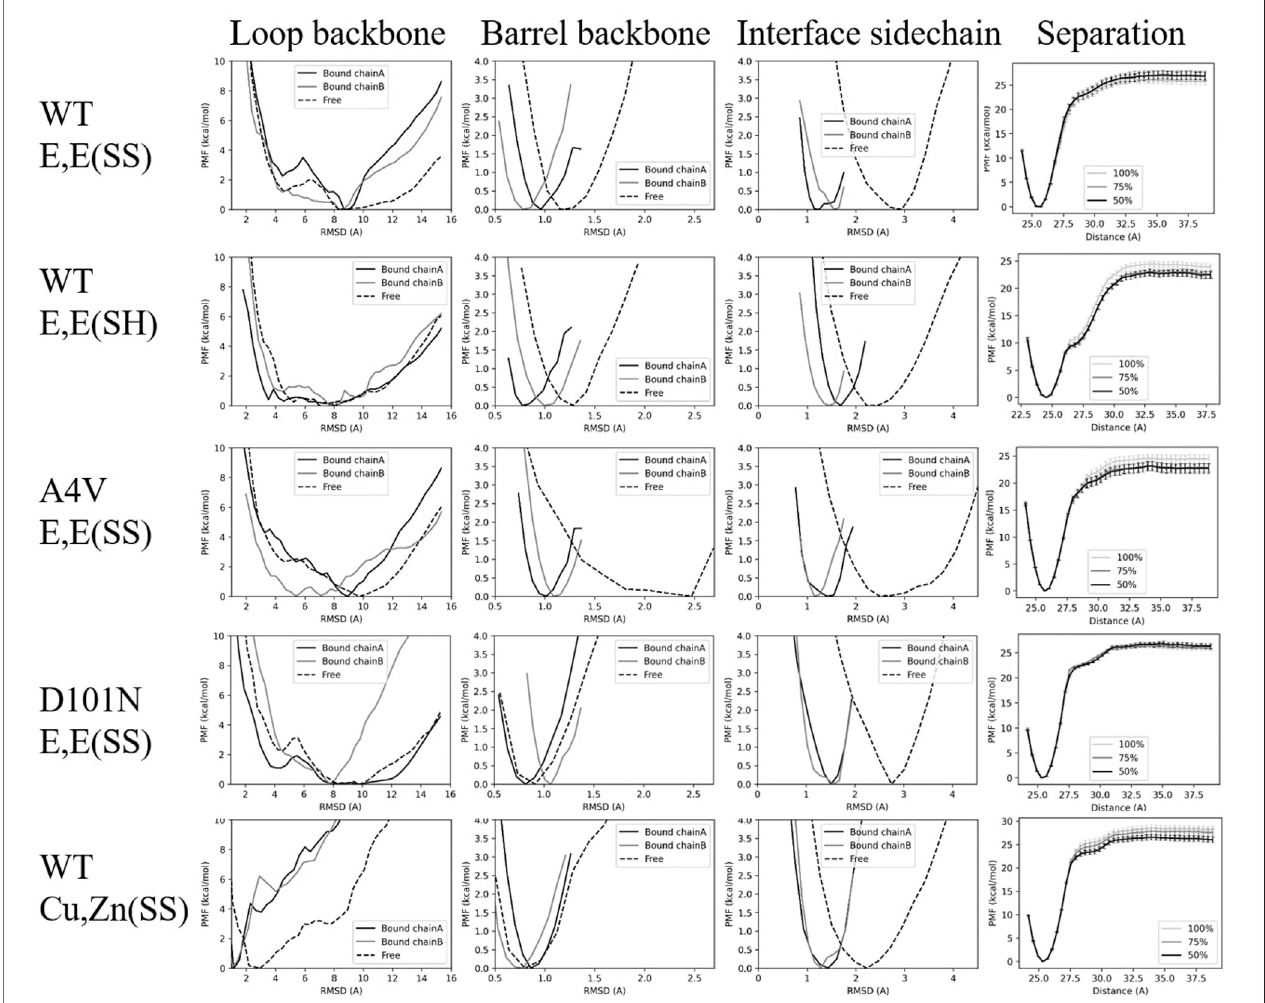
FIGURE3| PMFsforvariousrestraintsforeachvariant.EachrowshowsthePMFsurfacesforthevariousrestraintsappliedtoeachgivenvariant,andeachcolumn represents a given restraint: loop backbone, barrel backbone, interface sidechain, and inter-monomer separation distance. The PMFs labeled “ Bound chain A/Bound chain B ” correspond to varying umbrella restraints on the bound states of chain A or B respectively, while the PMFs labeled “ free ” correspond to varying umbrella restraints on the free state. The separation-distance PMFs are constructed using either the full, the last 75%, or the last 50% of the trajectories in REMD-US, as indicated in the